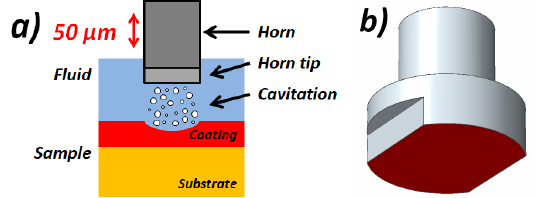
Figure 1. a) Schematic of the indirect cavitation test for a coated sample. b) Geometry of used horn tip - red area (115.7 mm 2 ) is closest to the sample and emitting cavitation